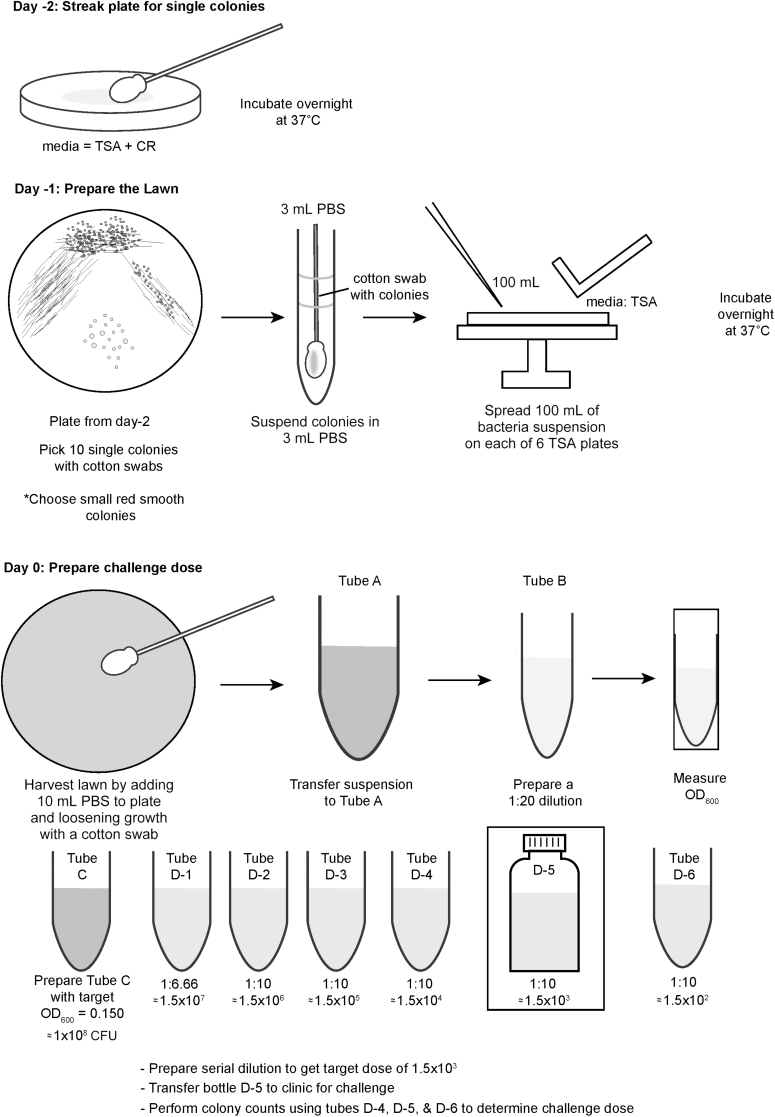
Inoculum preparation procedure. Abbreviations: CFU, colony-forming units; CR, Congo Red Dye; OD600, optical density 600 nm; PBS, phosphate-buffered saline; TSA, trypticase soy agar.